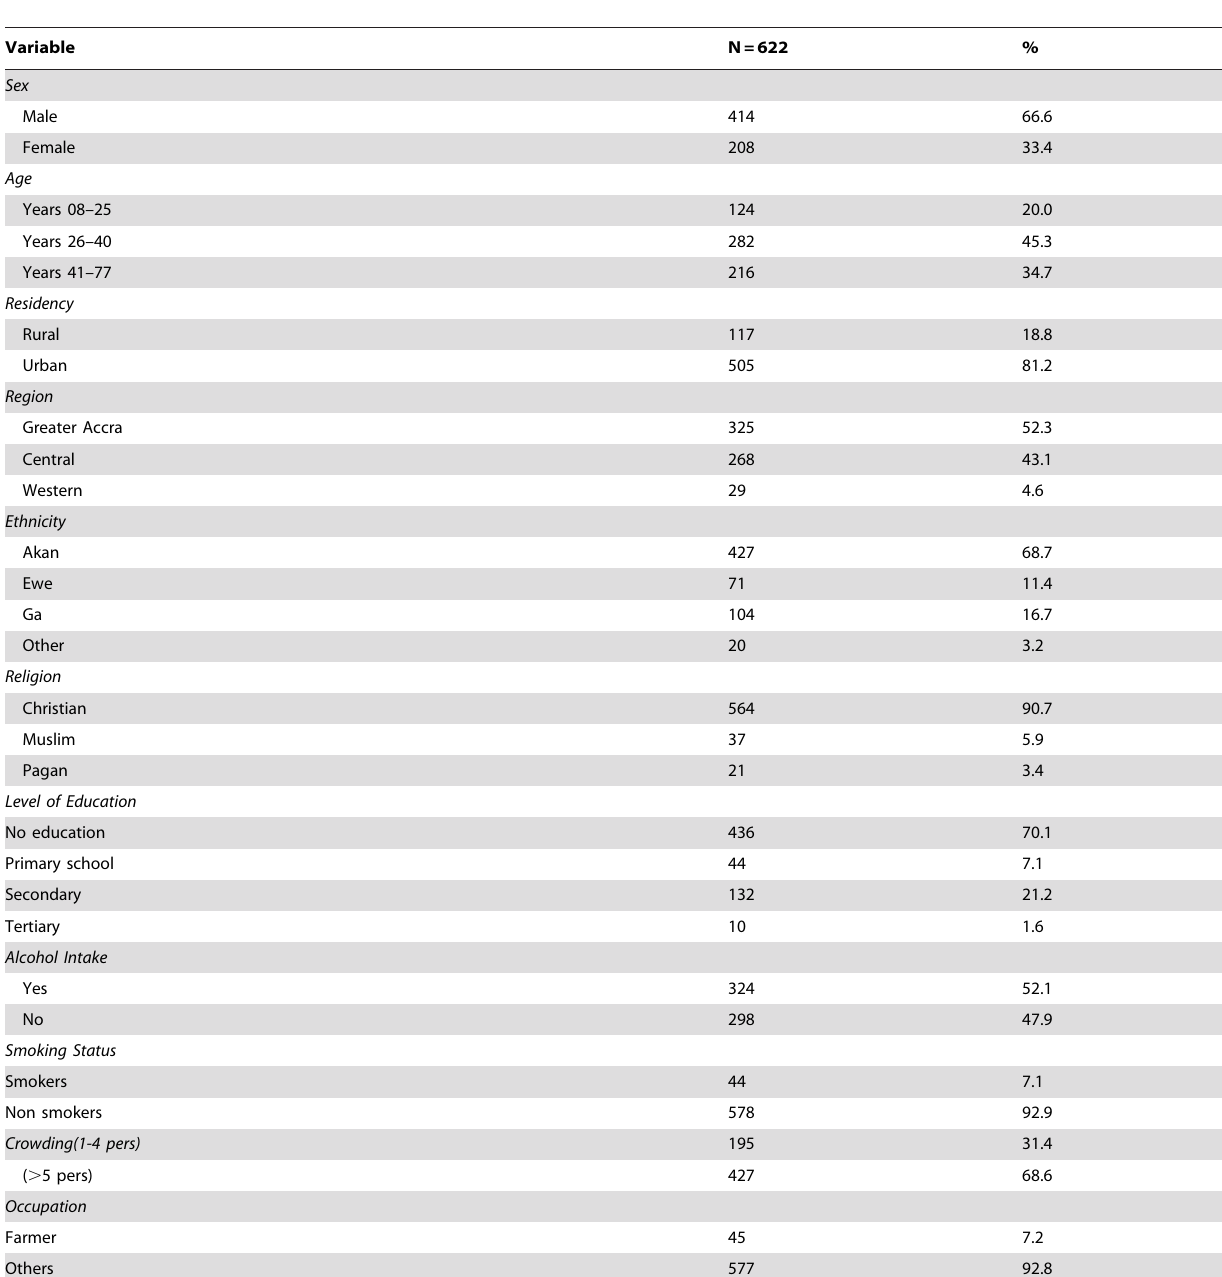
Table 1. Characteristics of patients included in the study.